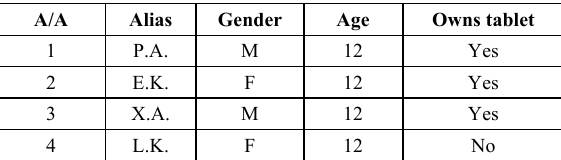
Table 2. The participants of the